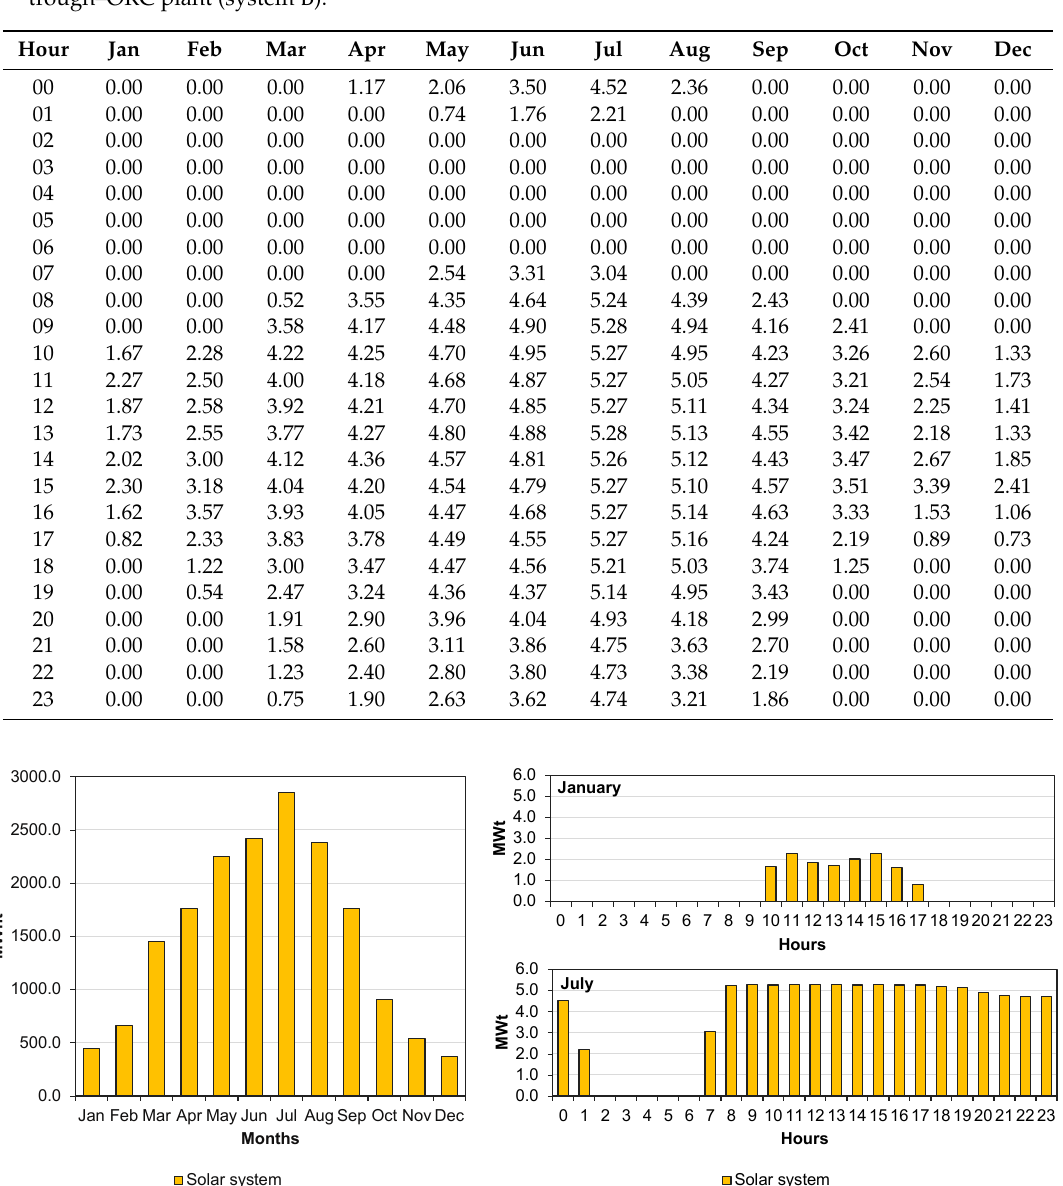
Figure 15. System B. Monthly thermal energy ( left side ) and hourly thermal energy ( right side ) of the solar field.